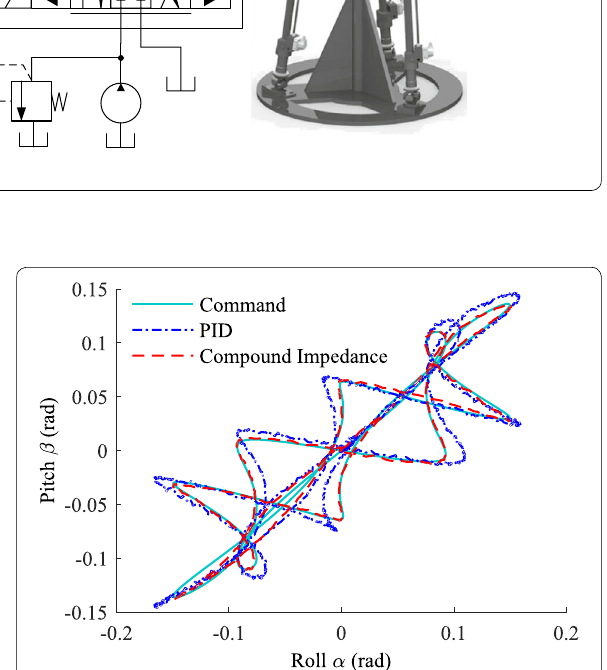
Figure 12 Trajectory tracking curves in the pitch-roll